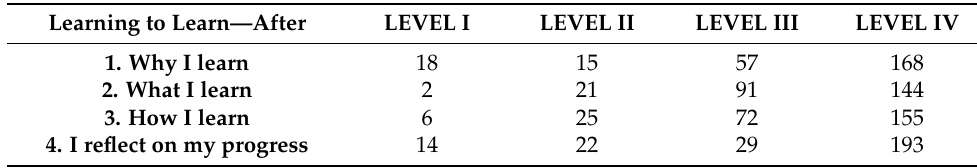
Table 3. Acquiring learning to learn competence (post-test) by dimension and level of progression (n =